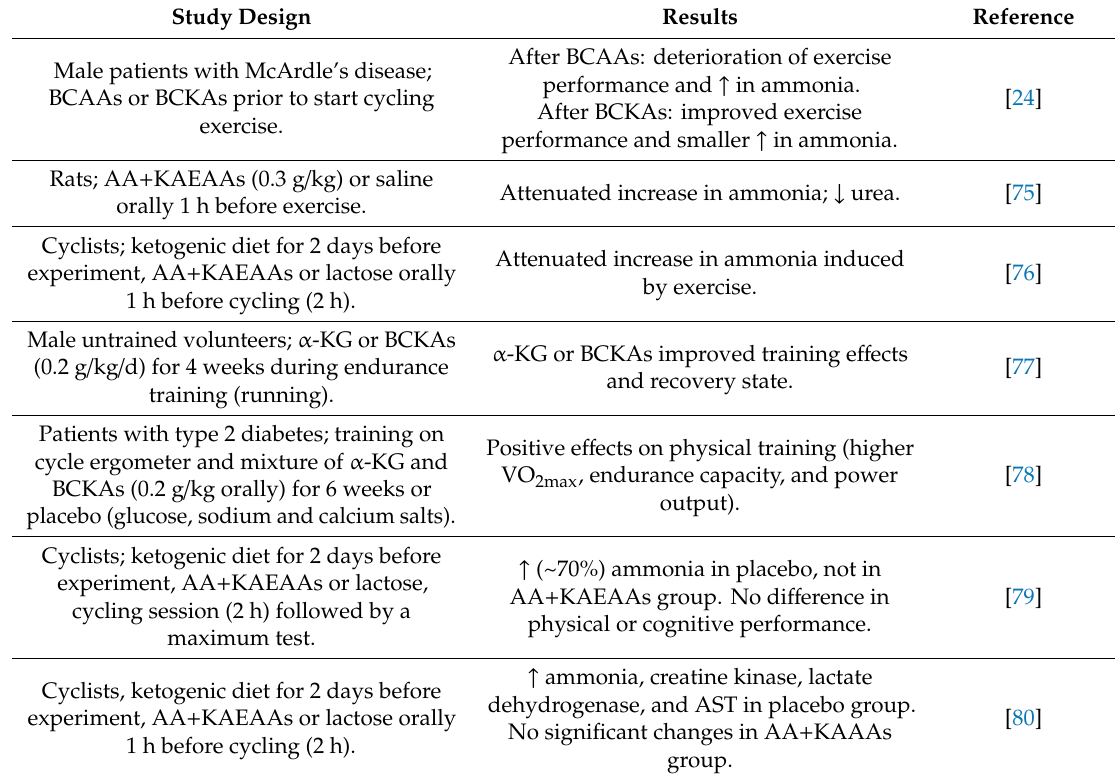
Table 3. E ff ects of KAEAAs and BCKAs on ammonia in